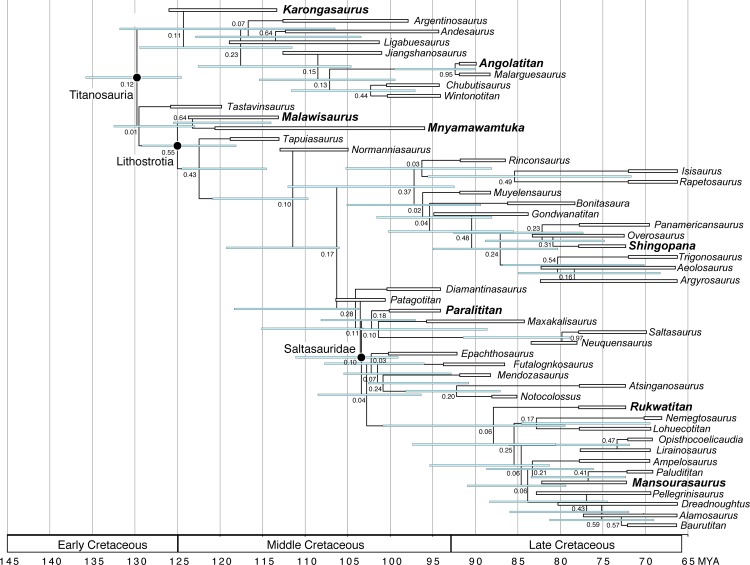
Results of tip-dating phylogenetic analysis.Maximum clade credibility tree for the variable-rates tip-dating Bayesian analysis. Numbers at the nodes represent posterior probabilities, blue bars at each node represent the 95% highest posterior density of each node age, and white bars at the tips represent the 95% highest posterior density of the sampled stratigraphic range of each terminal taxon. Abbreviations: MYA, millions of years ago.